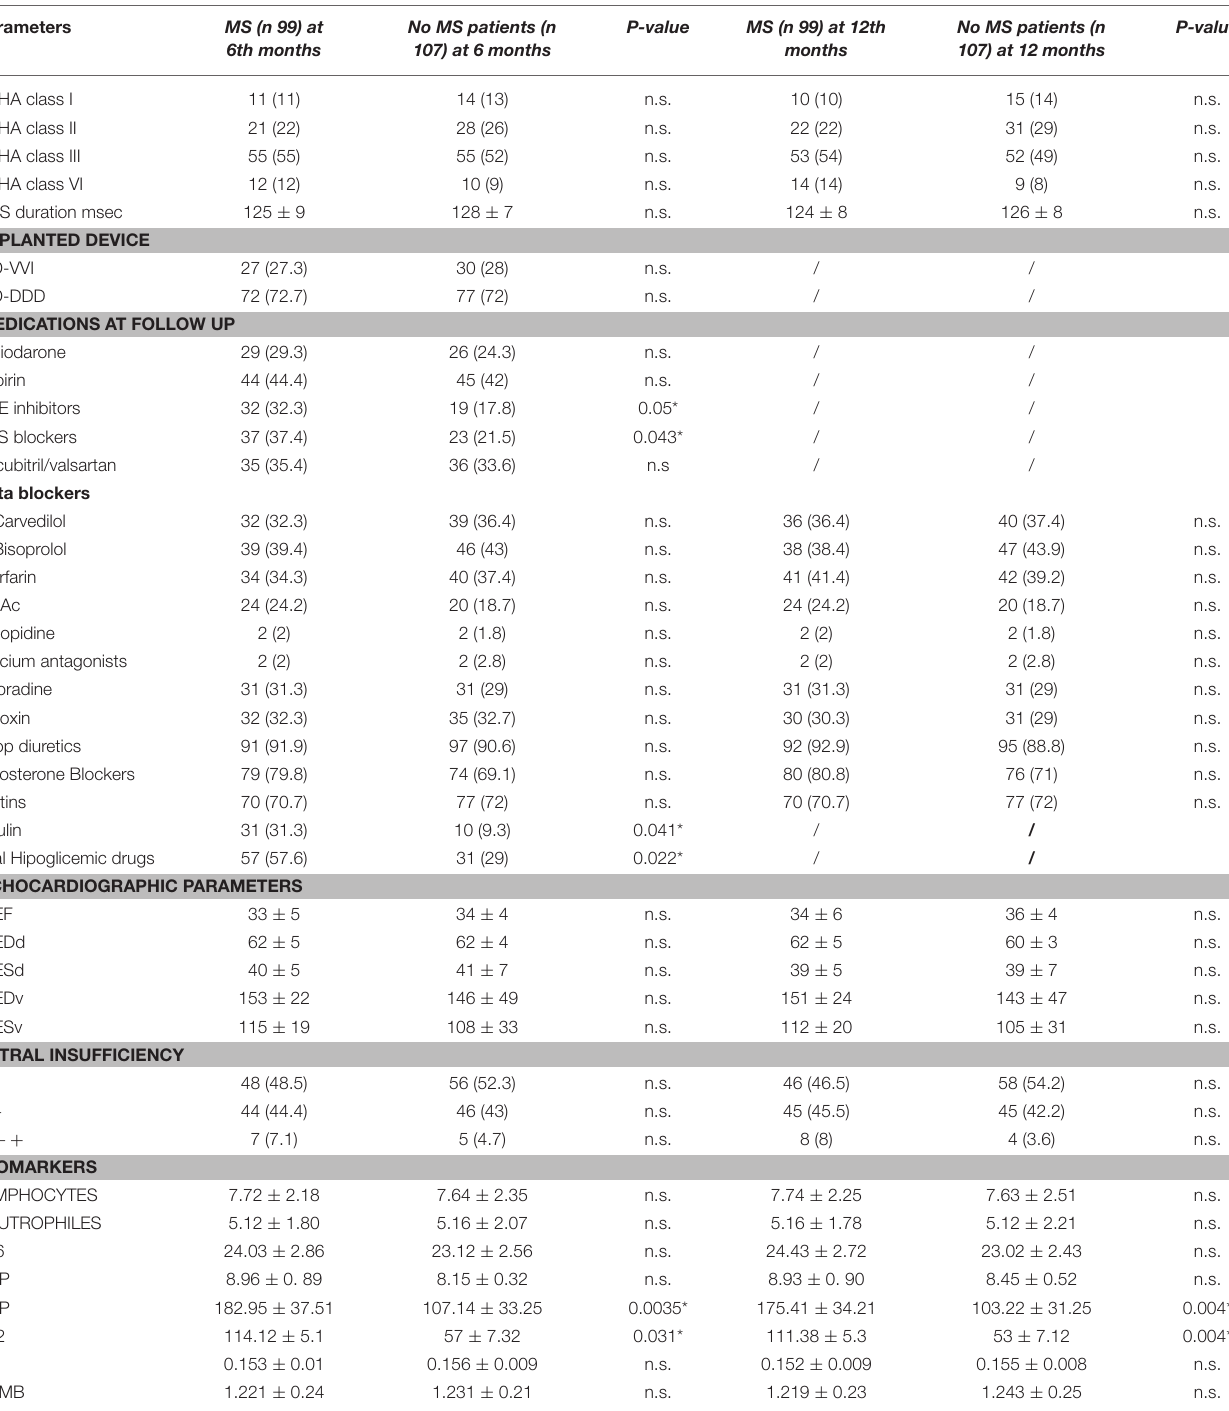
TABLE 2 | Study population in metabolic syndrome (MS) patients at 6 months and 12 months of follow up.